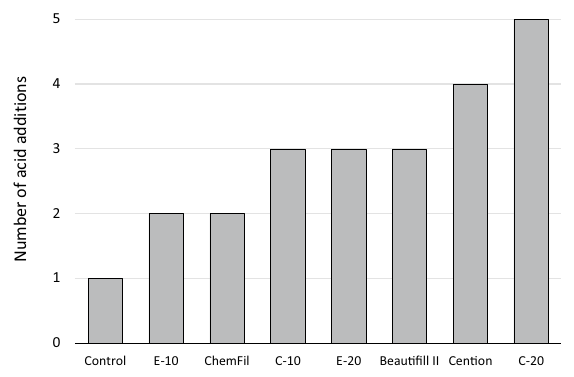
Figure 2. Number of acid addition cycles for which enamel surface MH remained statistically similar to initial